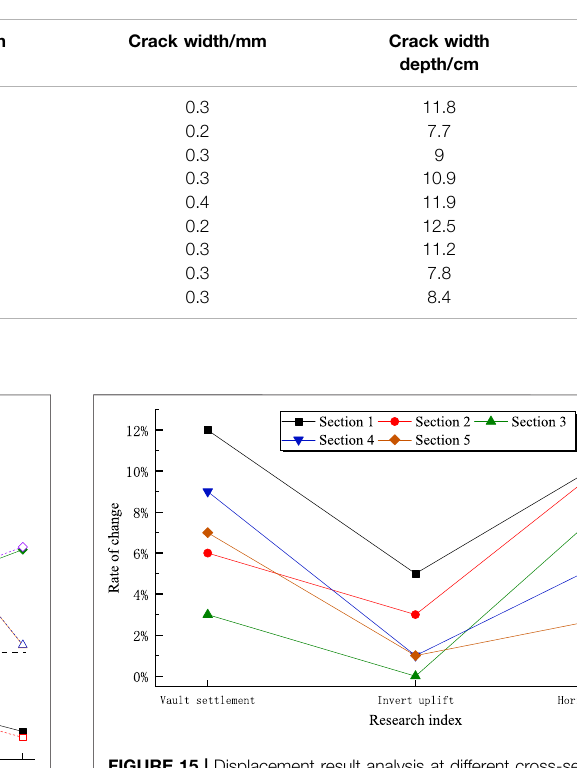
FIGURE 15 | Displacement result analysis at different